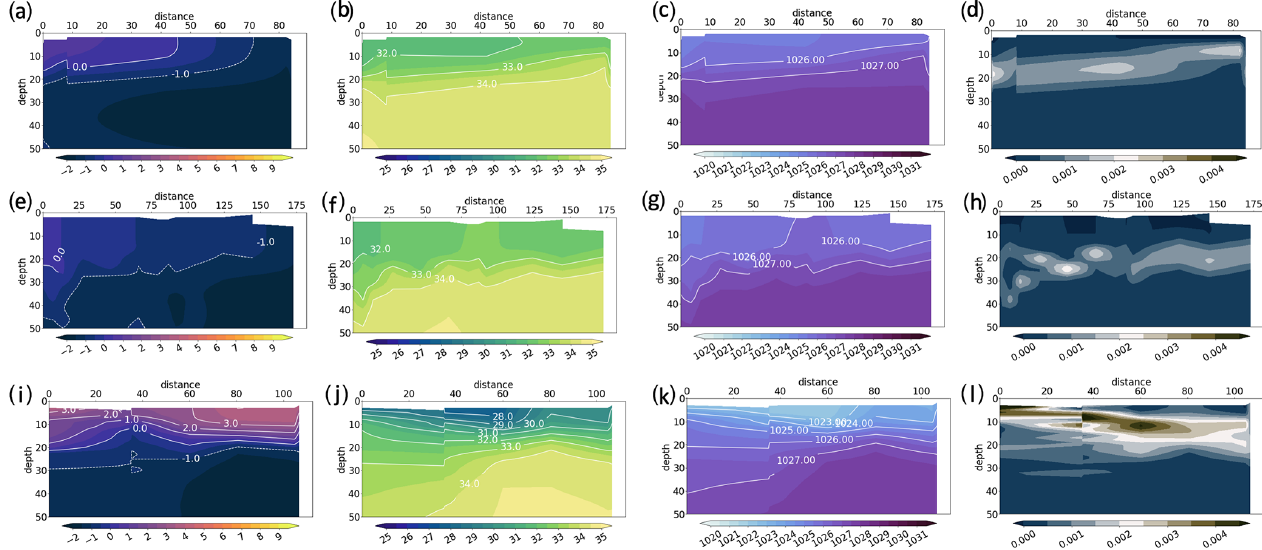
Figure 11. Temperature ( ◦ C; left, first column), salinity, (second column), water density (kgm − 3 ; third column) and buoyancy frequency, (s − 1 ; right, fourth column) obtained from CTD measurements in the upper 50m for transect 1 northward of Arkticheskiy Cape (upper row), transect 10 across the Shokalskiy Strait (second row), and transect 4 across the Vilkitskiy Strait (lower row). See Fig. 1 for the transects’ positions. The 0km point is always placed at the southern point of each